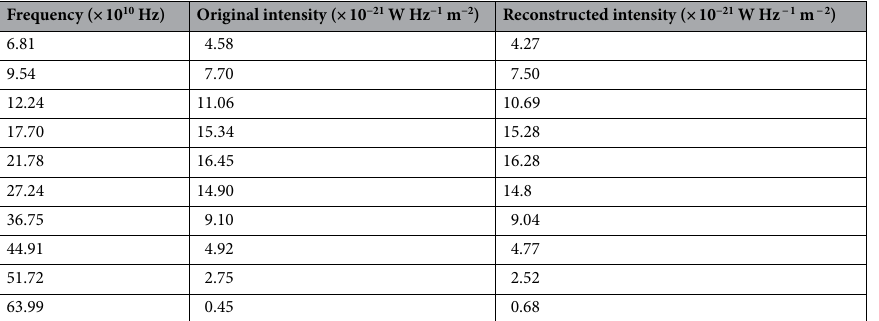
Frequency (× 10 10